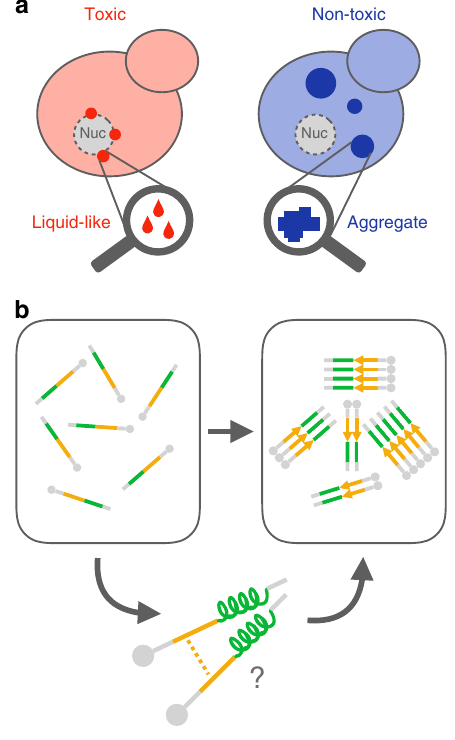
Fig. 5 Model of how AA changes determine toxicity of TDP-43. a Mutations that promote formation of insoluble cytoplasmic aggregates decrease TDP-43 toxicity, while mutations that cause the protein to stall in a liquid de-mixed phase increase its toxicity to the cell. b Secondary structure elements, within the toxicity hotspot 312 – 342, promote the aggregation process of TDP-43, with a transient helix forming on pathway to β